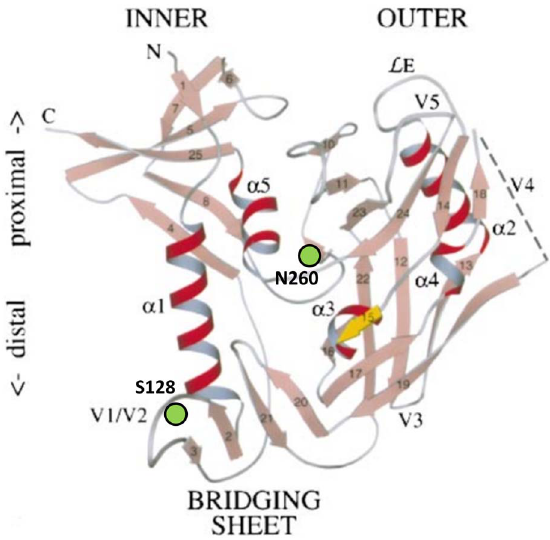
Figure 3. Infectivity of WT and mutant virus strains. Different concentrations of (WT and mutant) virus were added to C8166 cell cultures. Three to four days post infection, the viral infection was quantified by FACS analysis. Data ( 6 SD) are the means of 2 to 3 independent experiments.